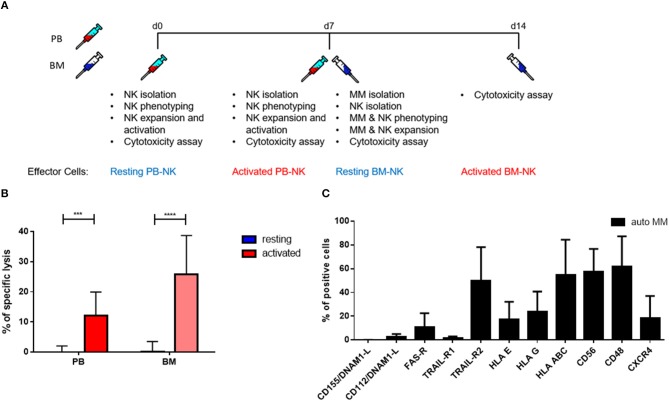
Pre-activation of NK cells significantly increases autologous tumor cell lysis. (A) Schematic of the experimental procedure. On d0, NK cells from peripheral blood were isolated and used for cytotoxicity assays at d0, before activation, and d7, after activation. On d7, MM cells and NK cells were isolated from BM aspirates. Those cells were also used for cytotoxicity assays at d7, before activation, and d14, after activation. (B) Resting and 7 days cytokine activated NK cells isolated from peripheral blood and bone marrow of patients were co-cultured for 24 h with CFSE-stained autologous multiple myeloma cells to compare the specific lysis of target cells. The percentage of dead tumor cells was determined with a live-dead stain (DAPI) via flow cytometry after 24 h of co-culture. NK cells and tumor cells were co-cultured with a 2:1 E-T ratio. (C) From patients, isolated primary multiple myeloma cells were stained with fluorochrome-conjugated antibodies to determine marker expression. For the bone marrow samples, 9 individual experiments with resting NK cells and 5 individual experiments with activated NK cells were performed (n = 5–9). For the peripheral blood samples, 9 individual experiments were performed (n = 9). For the phenotyping of autologous MM cells, 5 individual experiments were performed. Statistical analysis with two-way ANOVA + Tukey's multiple comparison: *p < 0.05, **p < 0.01, ***p < 0.001, ****p < 0.0001.